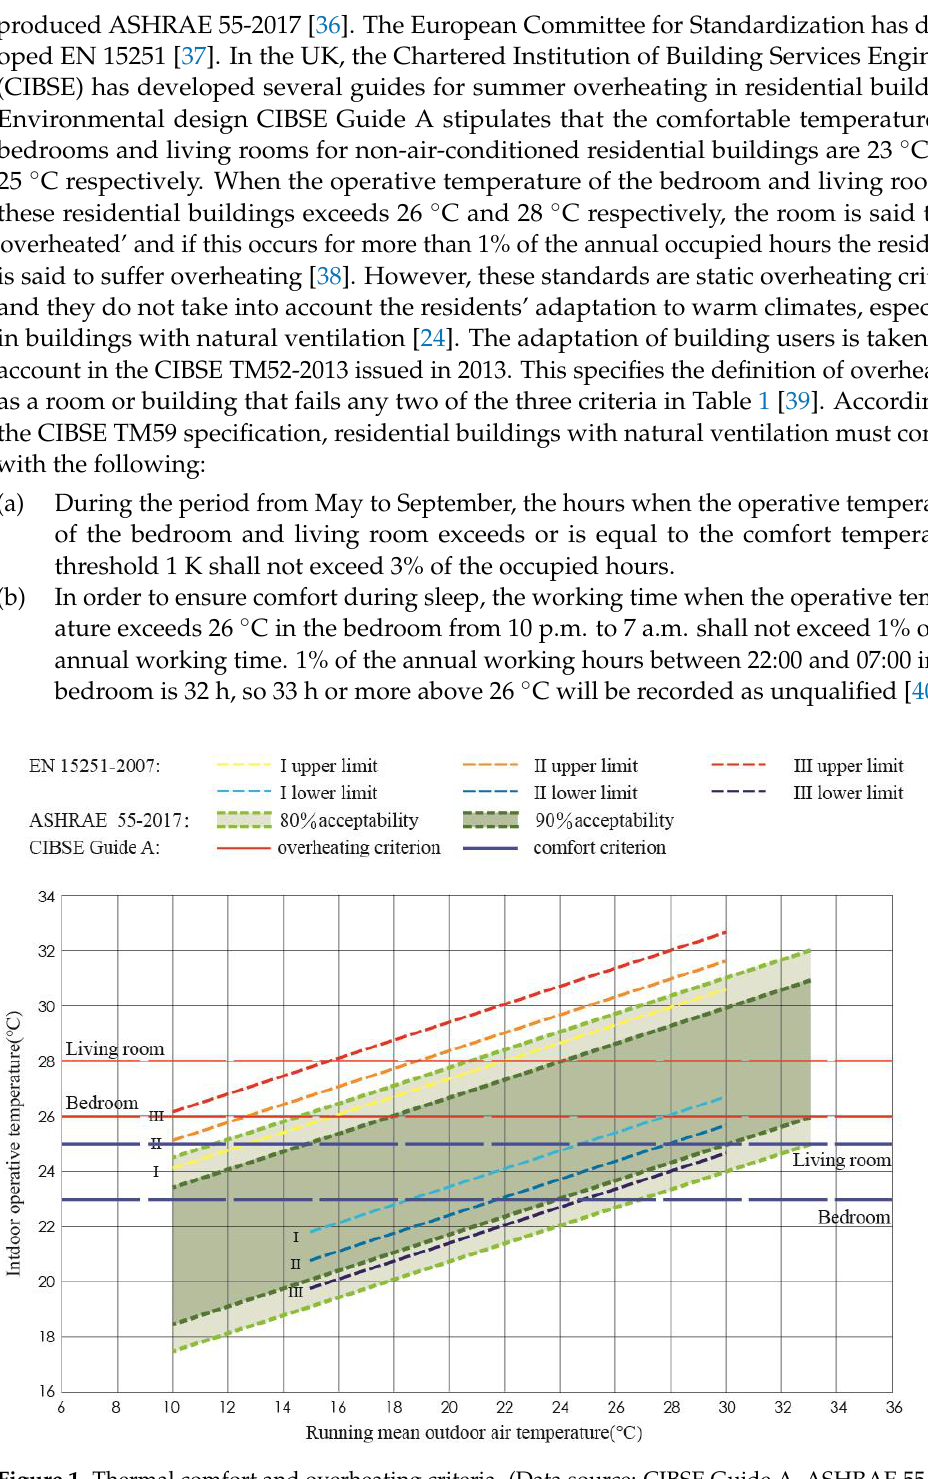
Figure 1. Thermal comfort and overheating criteria. (Data source: CIBSE Guide A, ASHRAE 55-2017, EN 15251-2007; drawn by the